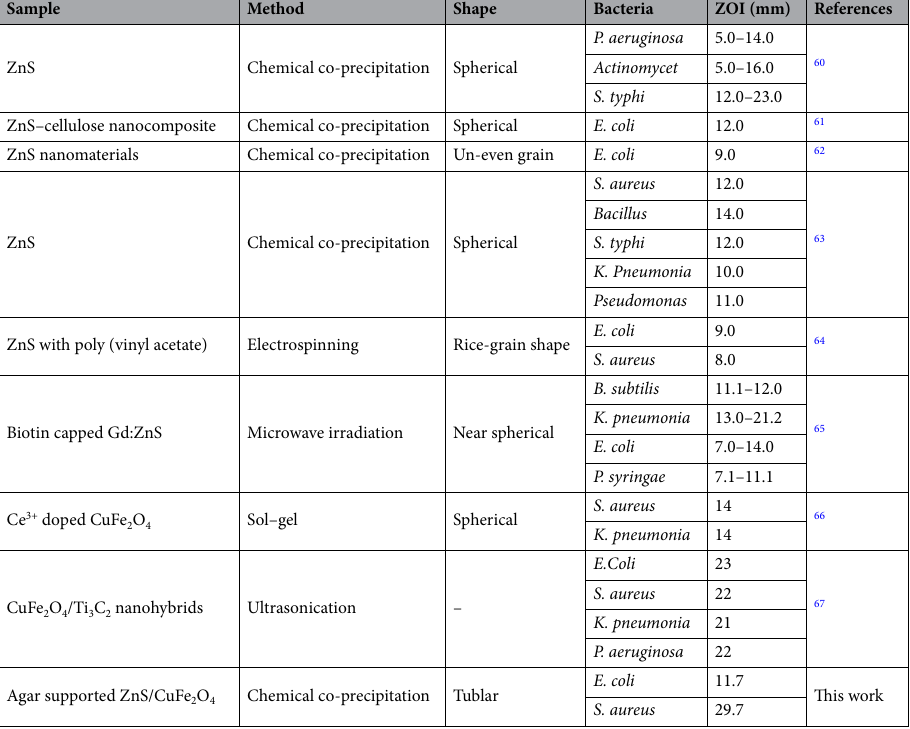
Table 5. Example reports on the antibacterial activity of ZnS or CuFe 2 O 4 -contained materials.